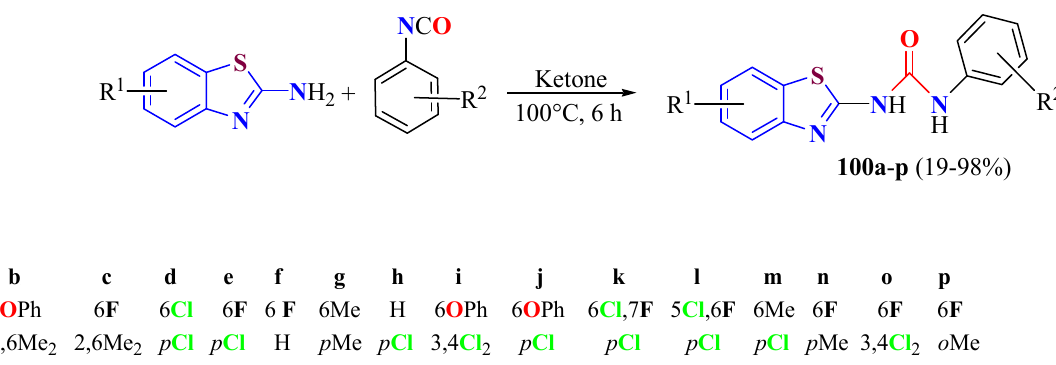
Scheme 41. Substituted aryl-UBTs 100xY from aryl-isocyanates in